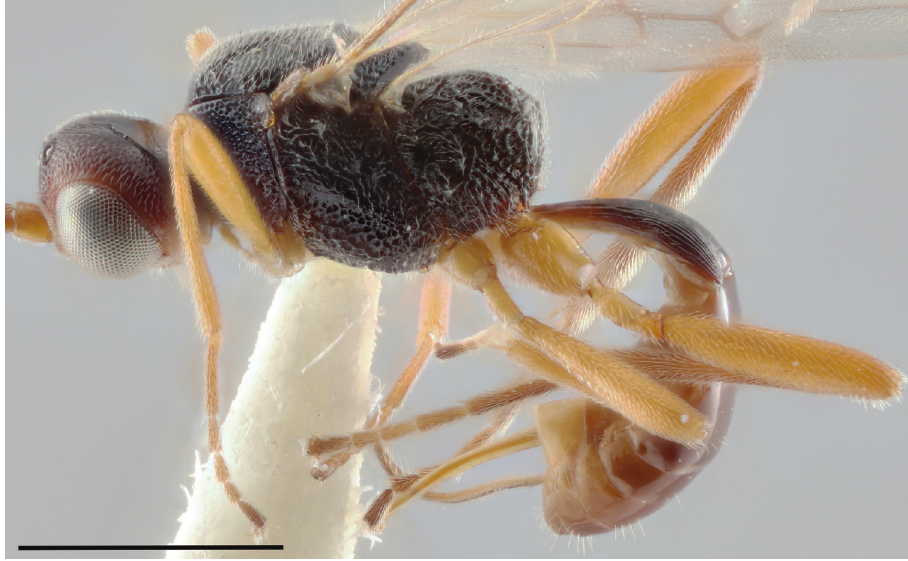
Figure 5. Unidentified Perilitus species from Cameroon (NHMUK014425412). Scale bar: 1 mm.